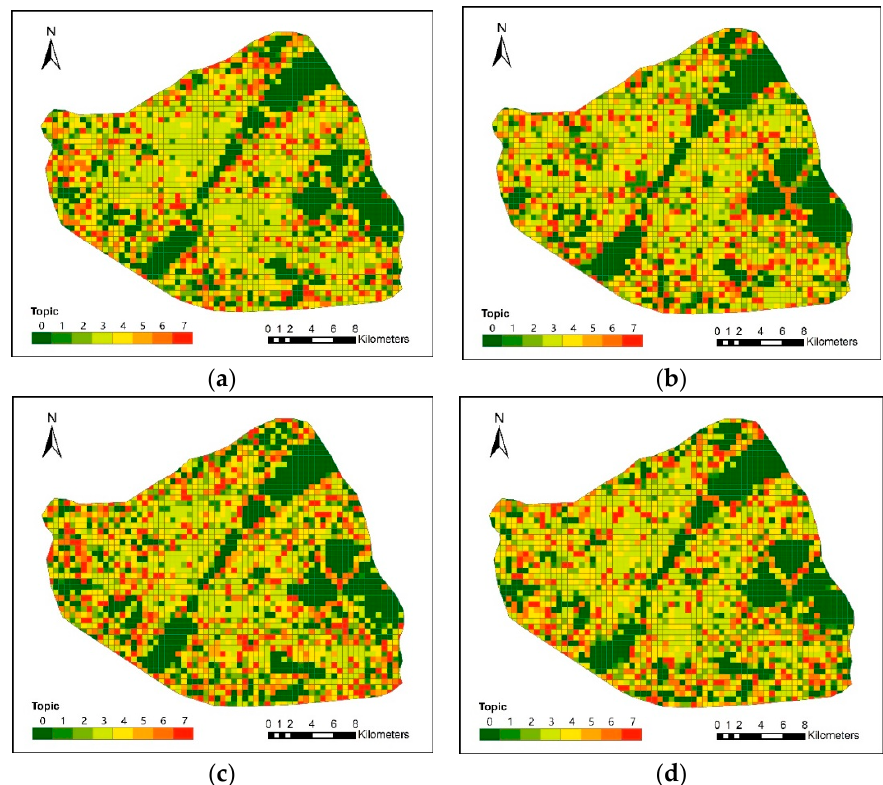
Table 2. Topic distribution under four groups of data.